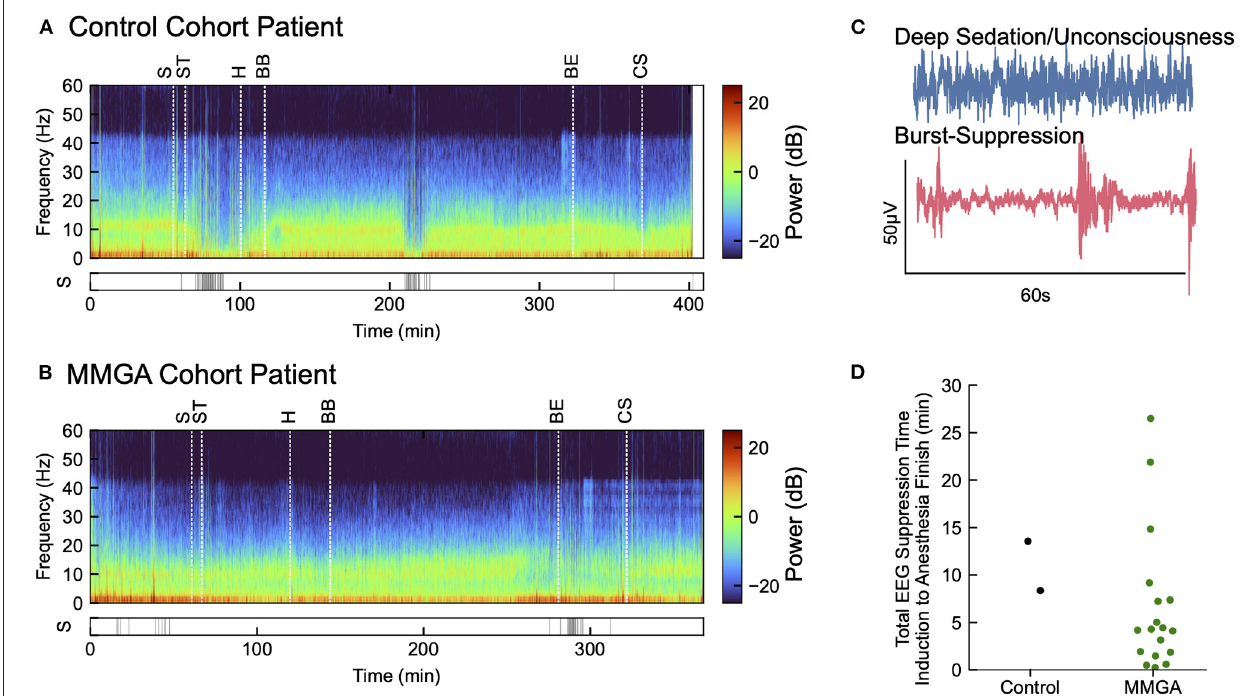
FIGURE 4 | Annotated recordings from one cardiac surgery using MMGA. (A) Computed EEG spectrogram for a selected MMGA cohort patient during cardiac surgery with labeled timepoints of surgical incision (S), sternotomy (ST), heparin bolus (H), bypass begin (BB), bypass end (BE), and sternal closure (CS) before ICU transfer. Suppression events are shown below spectrogram. (B) EEG spectrogram for a control cohort patient labeled as in (A) . (C) Selected 60s EEG epochs comparing a waveform during general anesthesia with a waveform during burst suppression, a coma-like deeper state of anesthesia. (D) Distribution of the of time spent in suppression from induction to anesthesia end for the MMGA ( n = 18, median suppression time = 4.24min, IQR [1.87, 7.33]) and control ( n = 2, suppression times 13.56min and 8.35min)